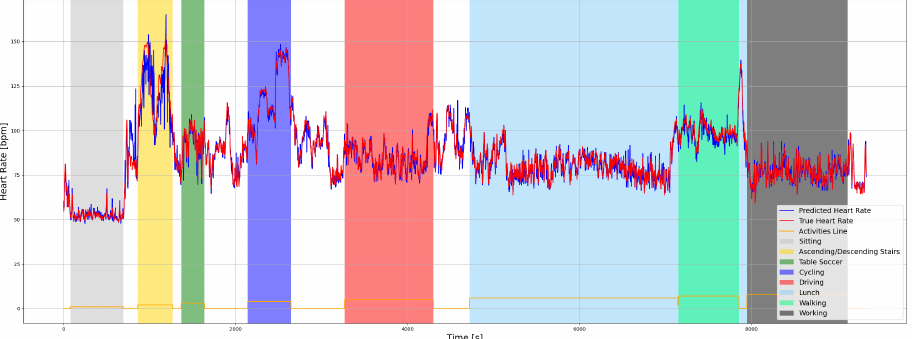
Figure 1. Participant S7 true and predicted HR using proposed MH Conv-LSTM